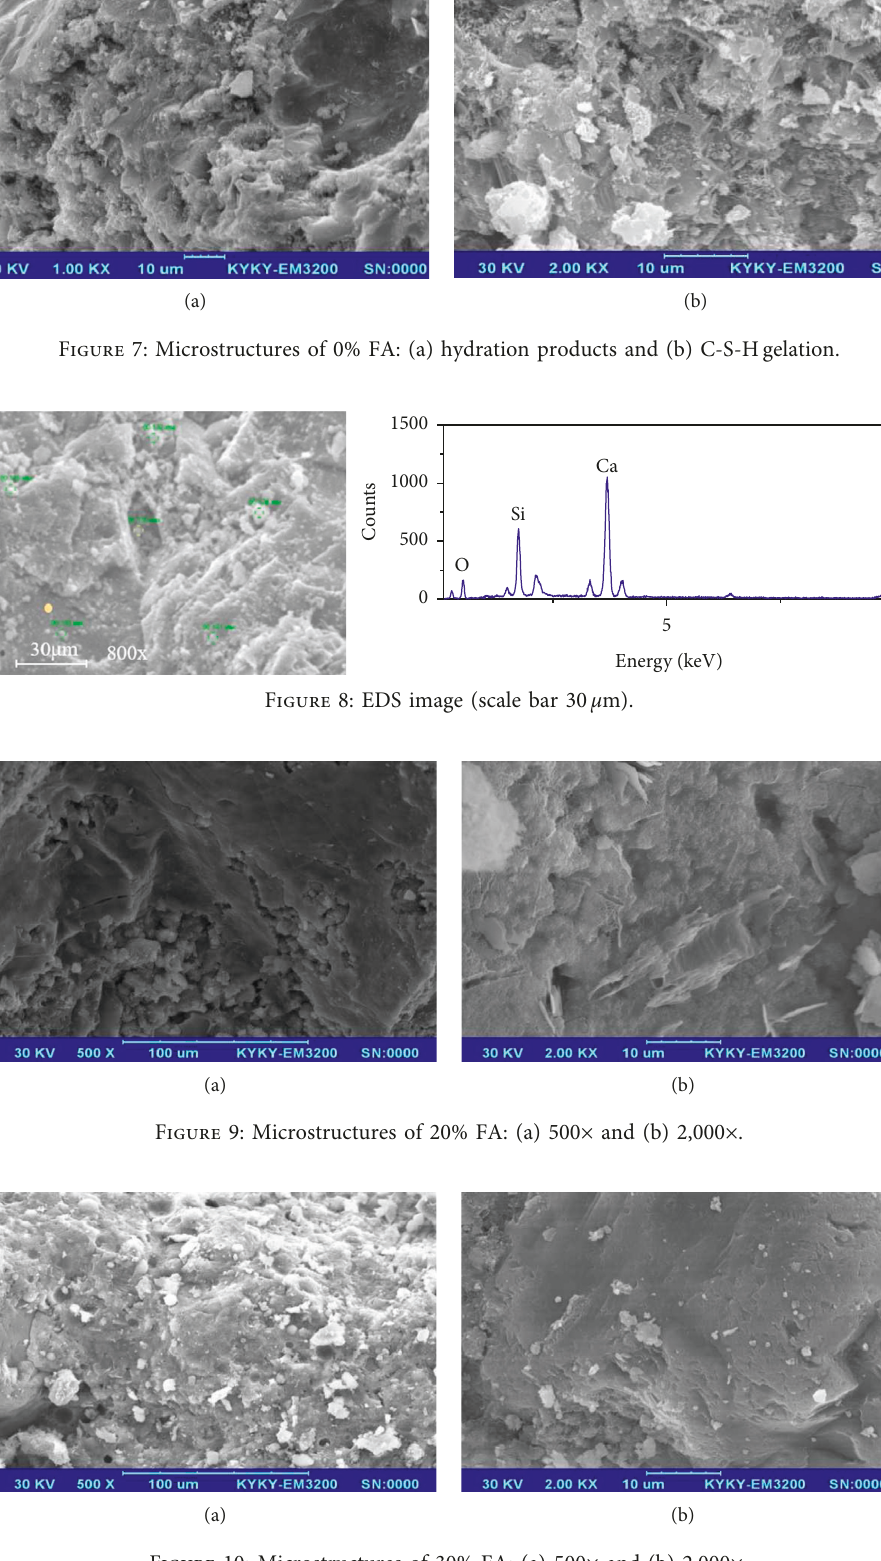
Figure 10: Microstructures of 30% FA: (a) 500 × and (b) 2,000 ×